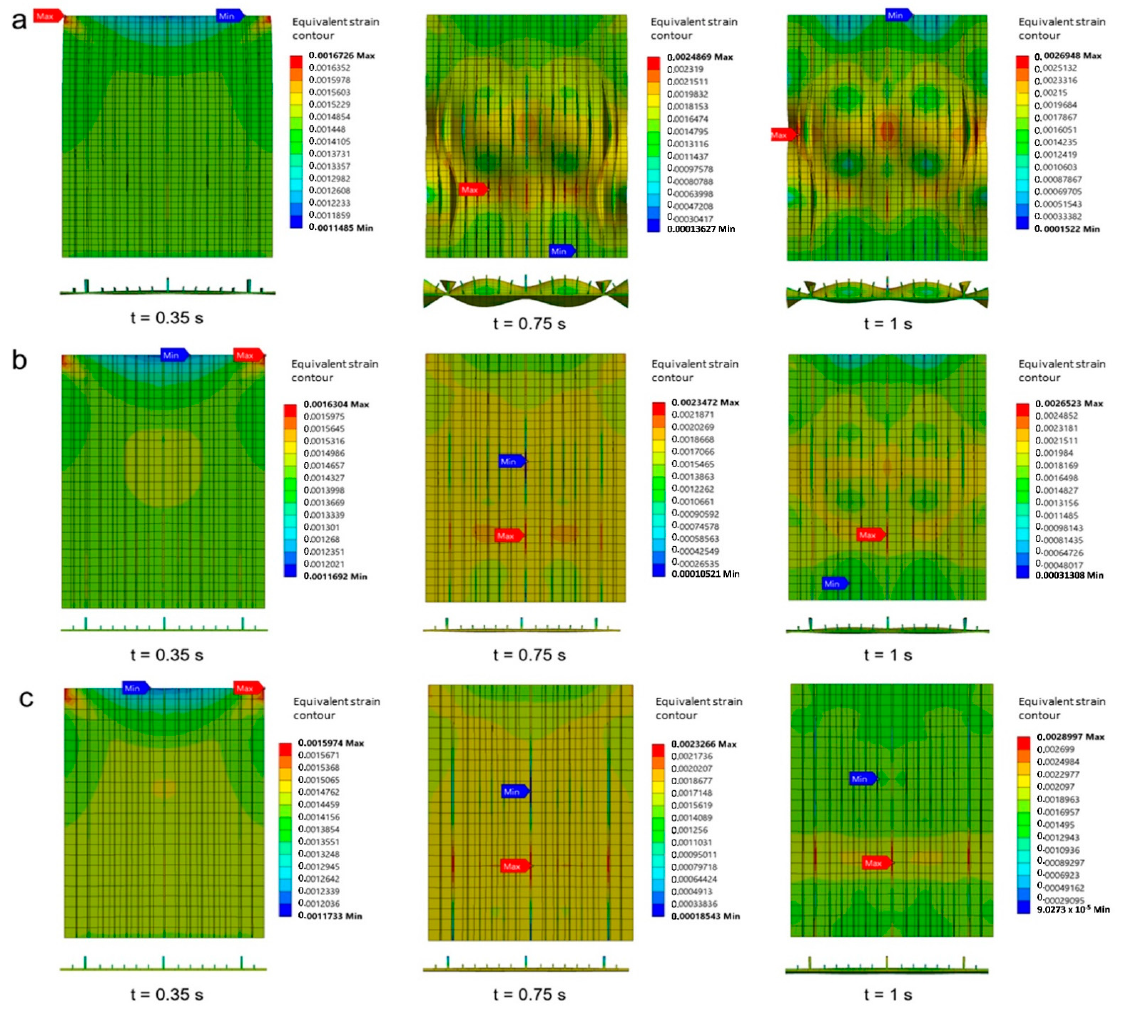
Figure 21. Equivalent strain contour in Specimen B: ( a ) 3 mm plate thickness; ( b ) 4 mm plate thickness; ( c ) 5 mm plate thickness.